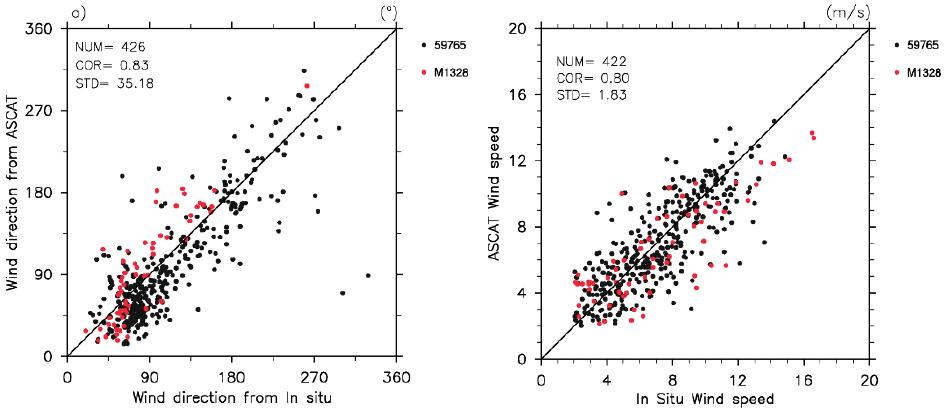
Figure 7. In situ wind directions ( left ) and wind speeds ( right ) vs. ASCAT wind.